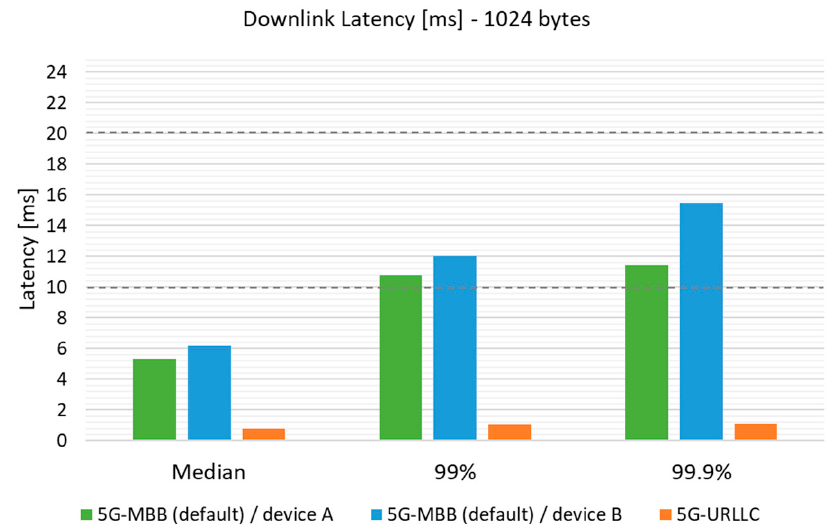
Figure 8. Downlink latency for 1024-bytes messages and different reliability percentiles (median, 99th percentile, 99.9th percentile).